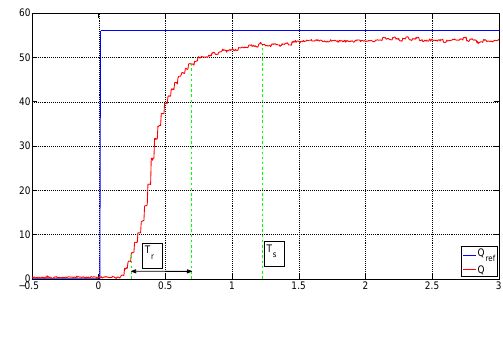
Figure 15: Step test with annotated settling and rise